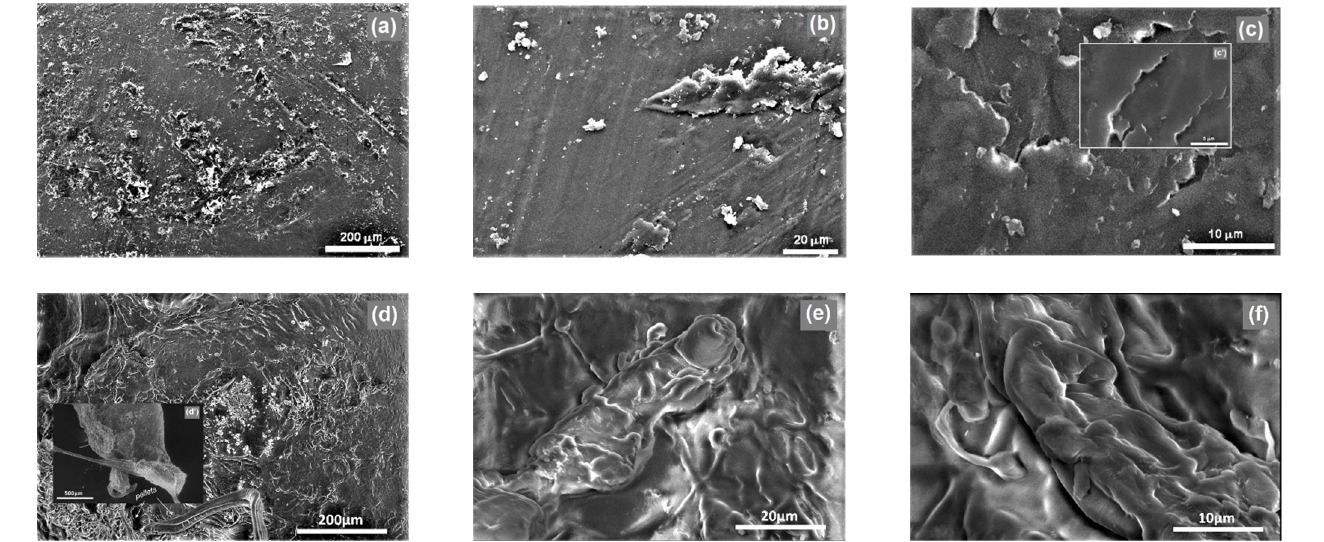
Figure 2. SEM micrographs of ( a – c , c’ )—PLA granules and ( d , d’ , e , f )—PLA powder, in different magnification.